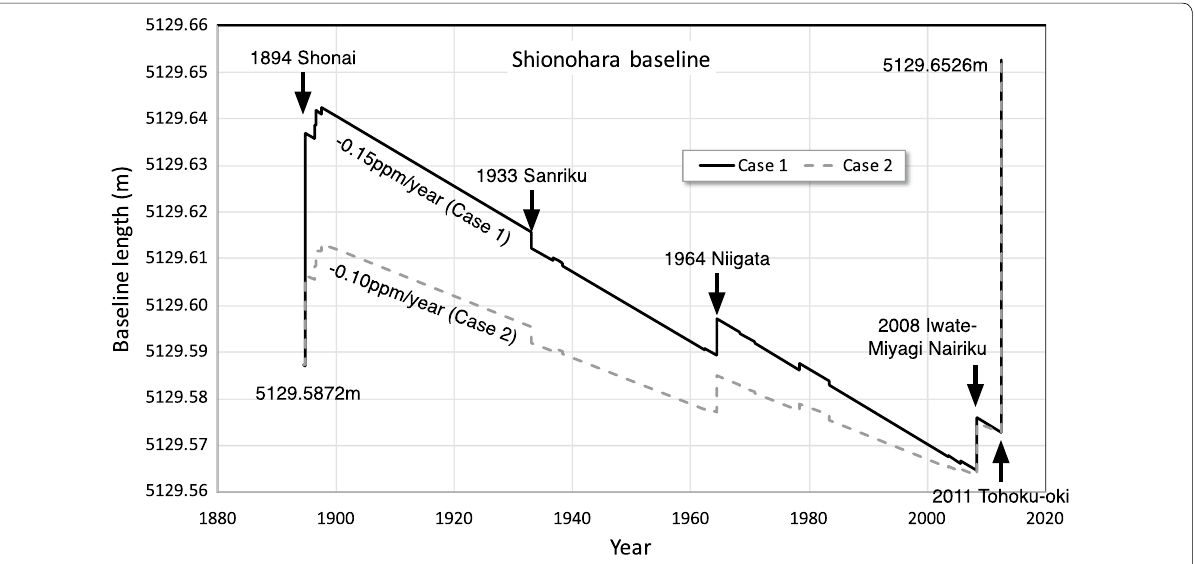
Fig. 9 Two scenarios of length change history of the Shionohara